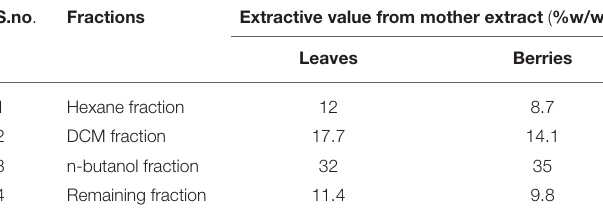
TABLE 1 | Tabular representation of extractive value of mother extract and its fractions of S. nigrum (leaves and berries). S.no .